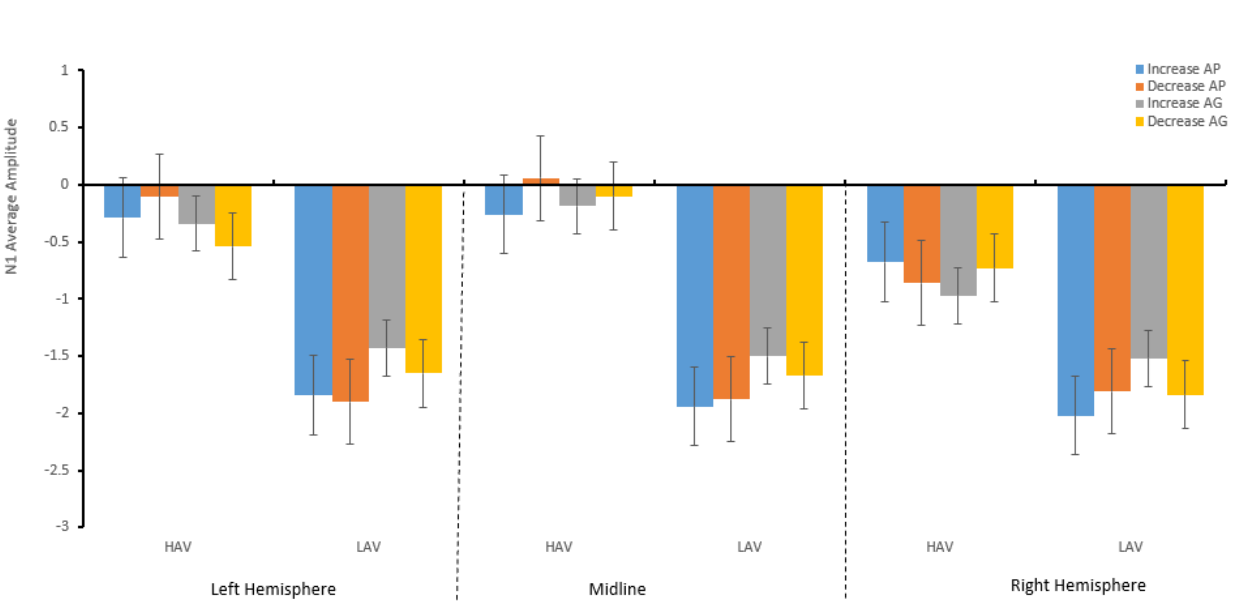
Figure 4. The descriptive statistics bar graph of the average amplitude of N1 regarding the hemisphere and emotion regulation. Table 4. N1 amplitudes (mean and standard error).